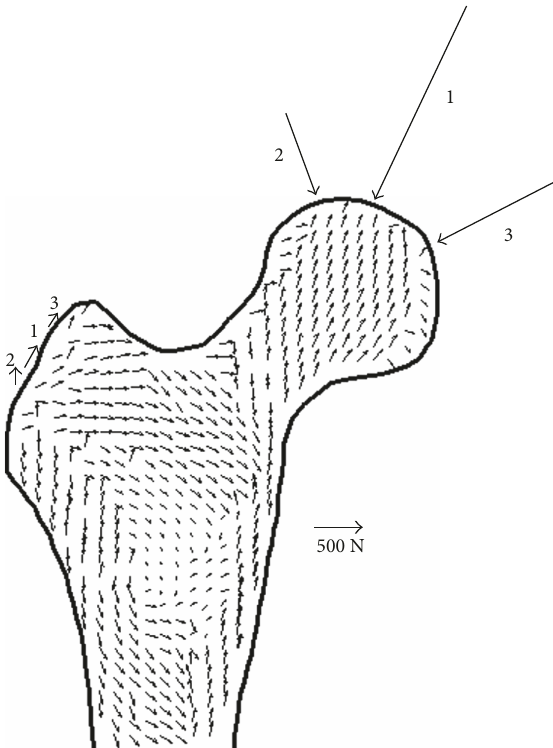
Figure 6: The projections of the element principal axes in coronal section. The orthotropic axes of each element were determined by three load cases according to the orthotropic algorithm, and only the fi rst principal axis is shown in the fi gure. The trabecular alignment is also displayed since the fi rst principal axis is the most sti ff ness axis, which aligns with the trabecula. The magnitudes and the directions of forces applied to the proximal femur in load case 1, 2, and 3 are also shown in the fi gure, and the magnitude of scale arrow is 500